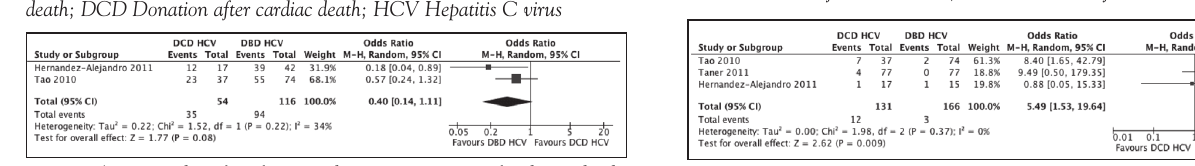
Figure 3) Forest plot of graft survival. DBD Donation after brain death;